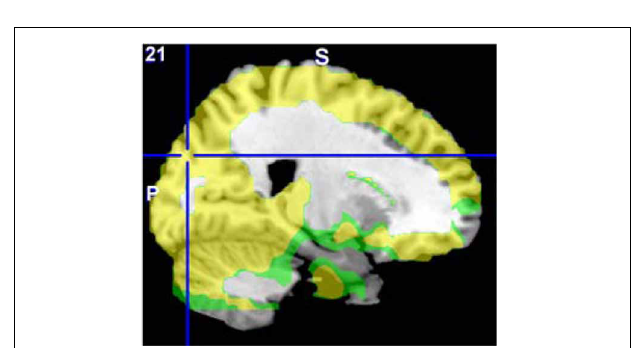
than did subjects with schizophrenia, thresholded at p < 0 . 05 (FDR corrected; t > 1 . 7) for the original and regressed fALFF (red and green,